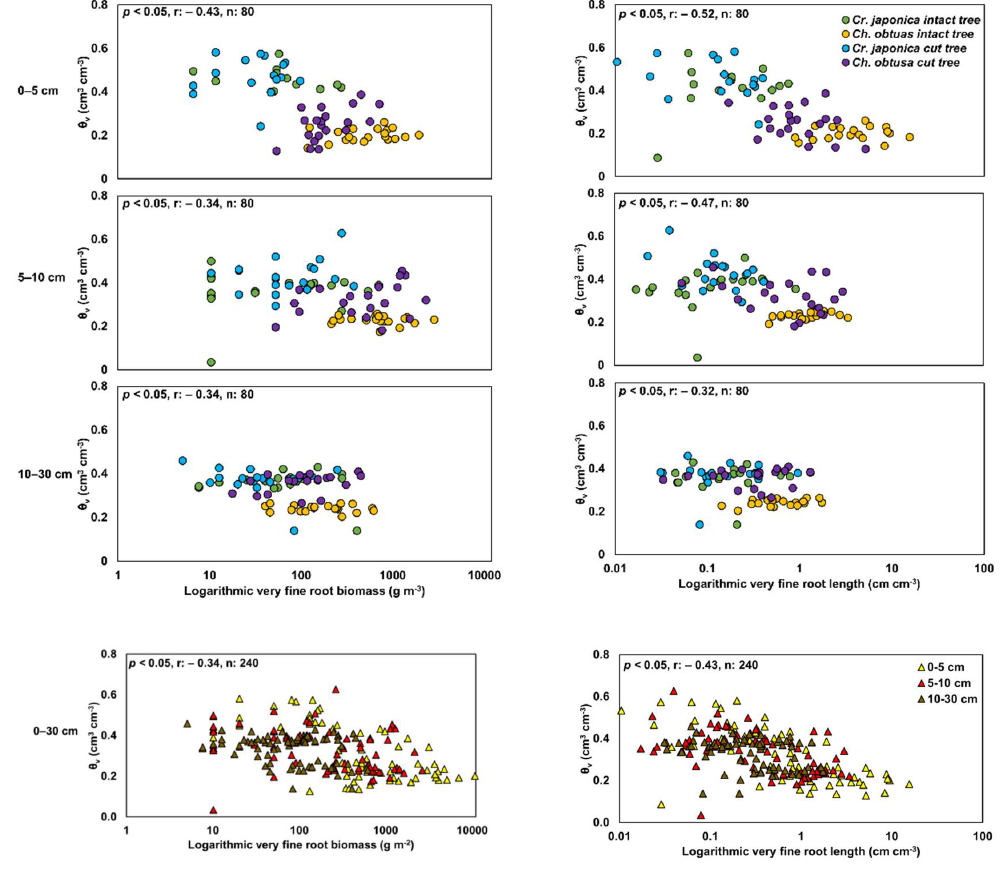
Figure 4. Pearson correlation coefficient ( r ) between soil water content ( θ v ) and very fine root biomass and root length density for different soil depths of Cr. japonica and Ch. obtusa intact tree and cut tree plots.